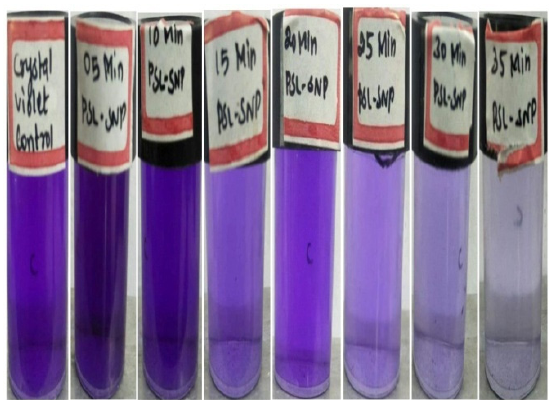
Fig. 7. Crystal Violet dye degradation of Pogostemon speciosus SNPs at various time